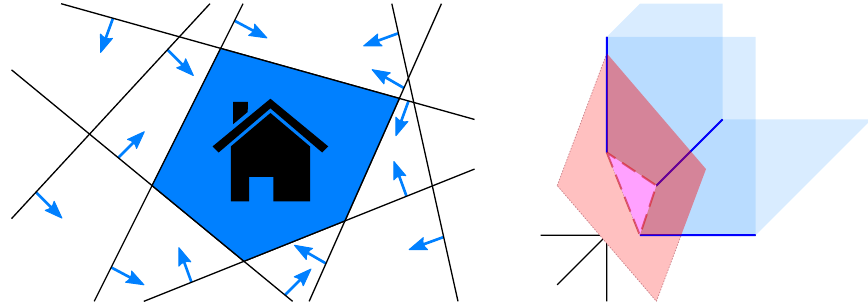
Figure 3. The containment check defines a container by the intersection of halfspaces ( left ). Each geometric part of the candidate model must be located in all specified halfspaces. In 3D, halfspaces are defined by planes ( right ). A triangle or polygon (red) with one or more vertices outside one of the defined halfspaces (blue) violates the